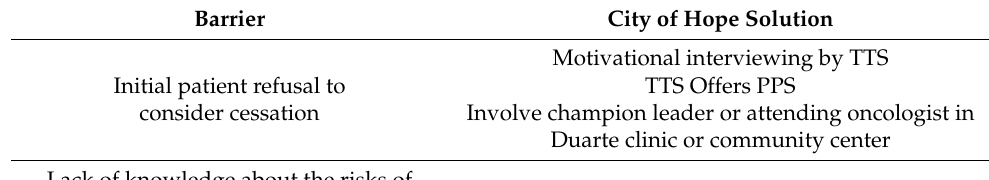
Table 2. Barriers and City of Hope Solutions for Tobacco Cessation and LDCT